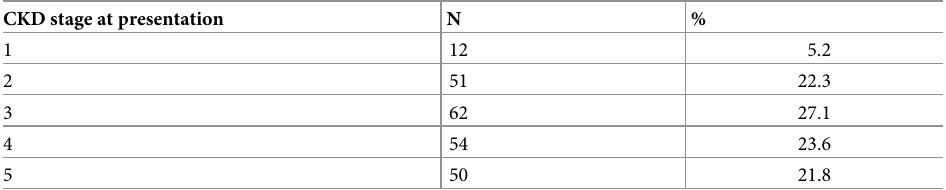
Table 2. CKD stage at presentation. CKD stage at presentation